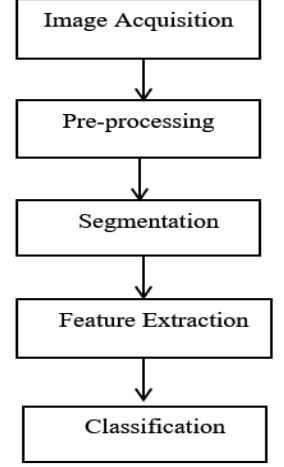
Figure 7. Flow Diagram of the Proposed